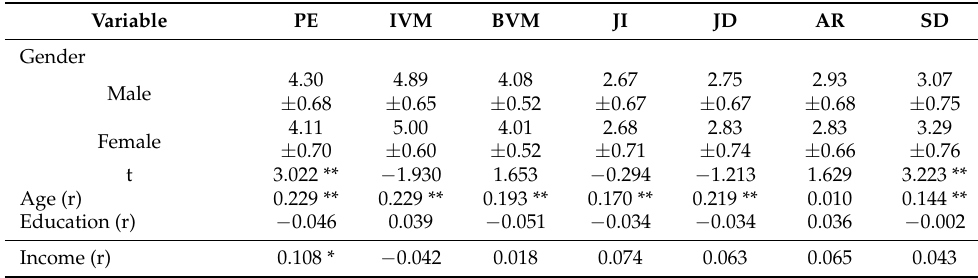
Table 3. Differences in the variables according to the demographic